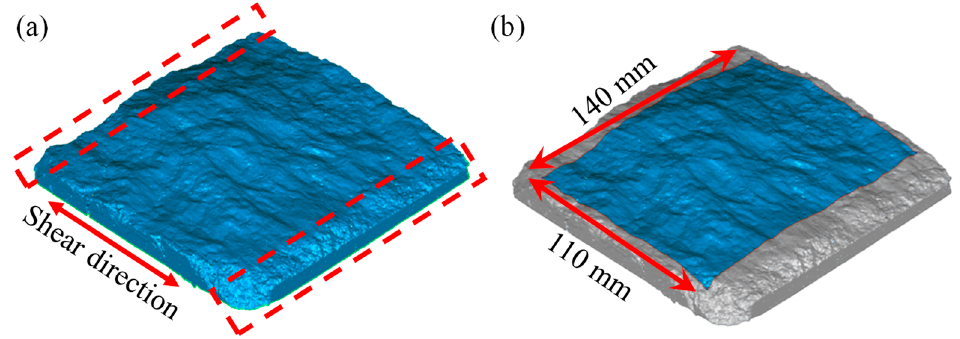
Figure 6. Measuring of the joint surface morphology via 3D scanning: ( a ) lost area due to breakage, ( b ) uniform roughness calculation and analysis area.